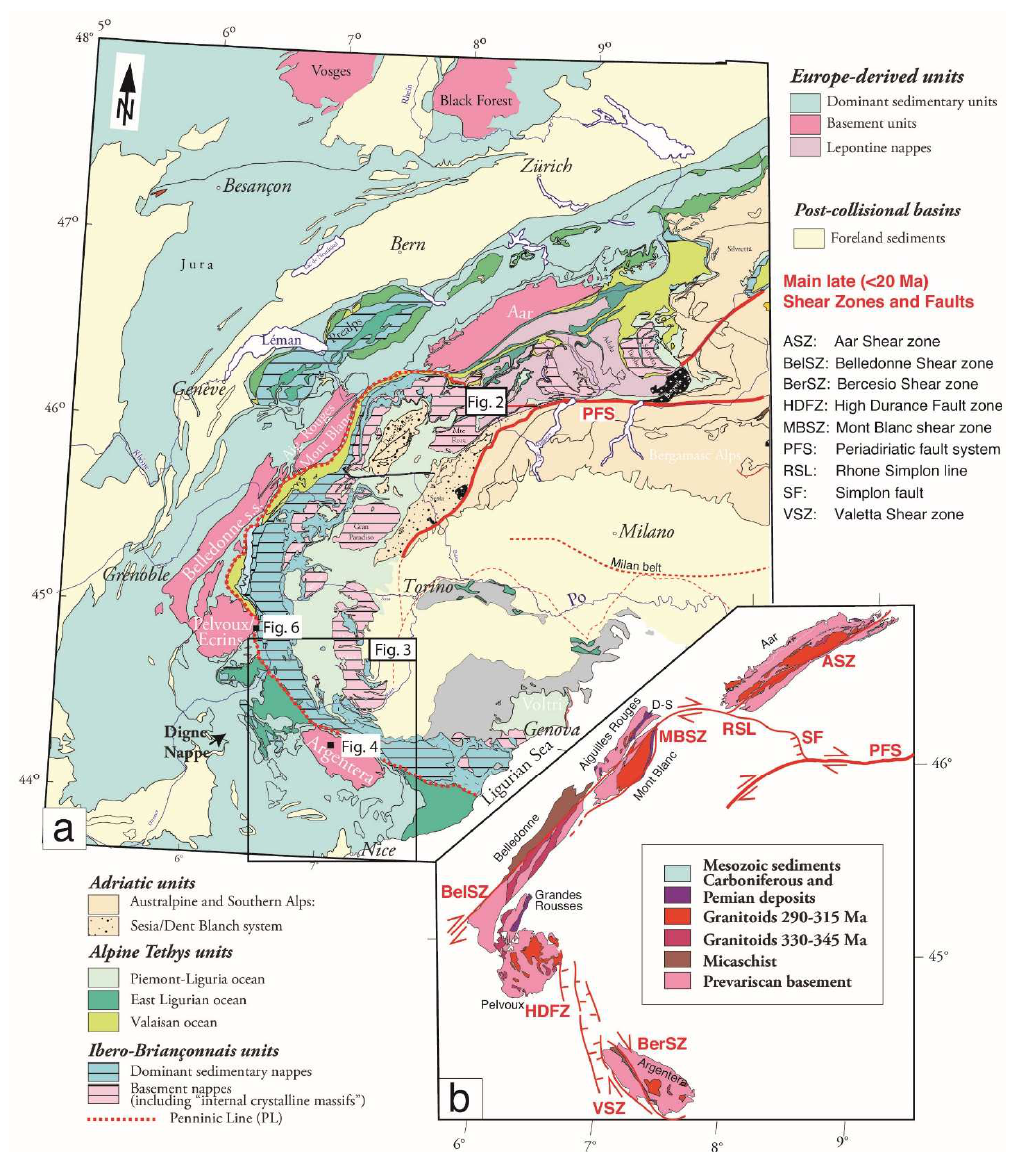
Figure 1. ( a ) Geological map of Western Alps, simplified after [42]. ( b ) Simplified sketch map with the main shear zones and faults reactivating the Penninic Front. The Penninic Line is thus a good example of a major fault system, the ongoing activity of which is shown by the seismicity. However, the presence of significant fault motions remains debated. A first input from thermochronology shows that the Penninic Line has clearly been active in recent geological history (<20 Ma), as emphasized by fission–track dating undertaken on both sides of this fault (e.g., [5,45,46]; Figure 2). Offset is well docu- mented along the Simplon normal fault, which is a local extensional domain connecting